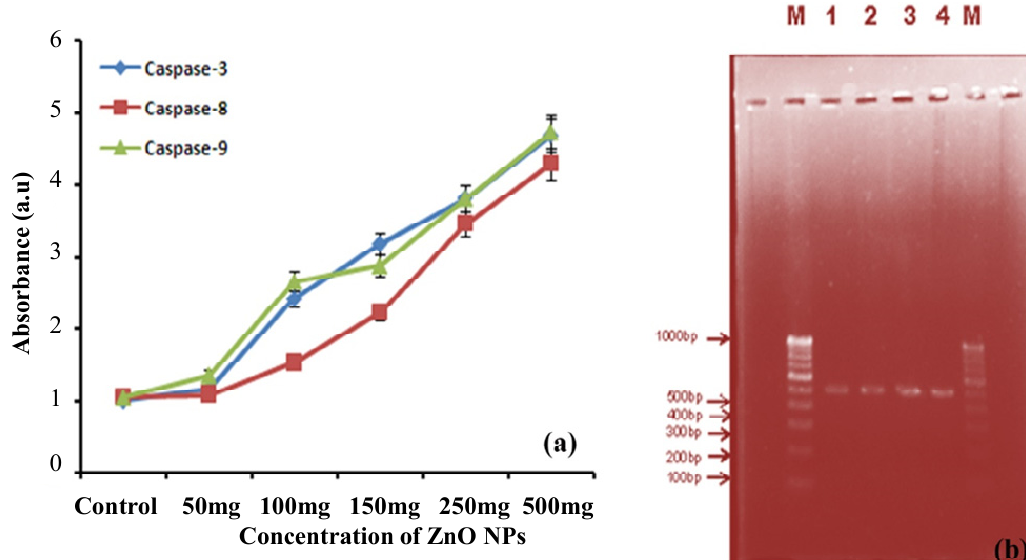
Figure 5. ( a ) Caspase-3, Caspase-8 and Caspase-9 activity of synthesized ZnO NPs; ( b ) DNA fragmentation: M is 100 bp DNA ladder used as a marker DNA; 1-Control (medium); 2-Camptothecin treated; 3-Doxorubicin treated and 4-DNA of ZnO NPs treated cells showing a large DNA ladder indicates more